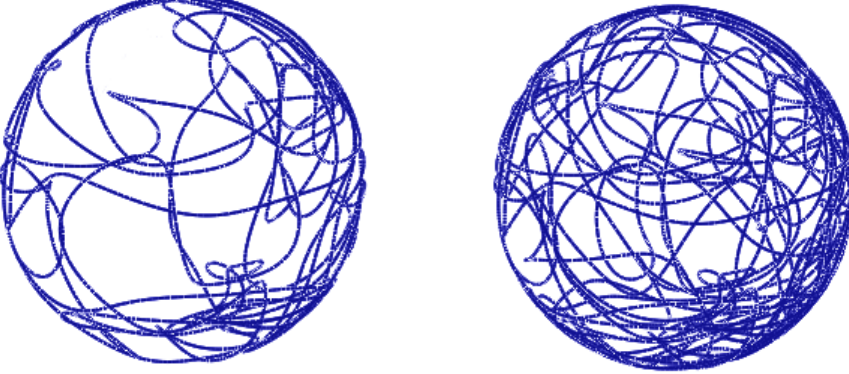
Figure 8. Angular velocity of buckminsterfullerene.